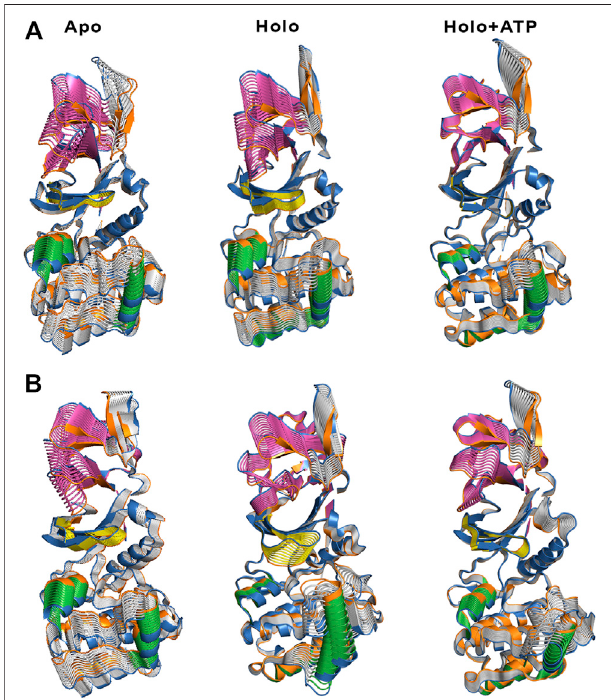
FIGURE 4 | Representation of the fi rst essential motion derived from the ED analysis of the protein backbone for the (A) α 2 β 1 and (B) α 2 β 2 species, determined from the snapshots sampled along the last 500 ns of MD simulations. The P-loop is shown in yellow, and the helices formed by residues 100 – 110 and 220 – 229 in the α -subunit are shown in green . The CBM domain is colored in magenta